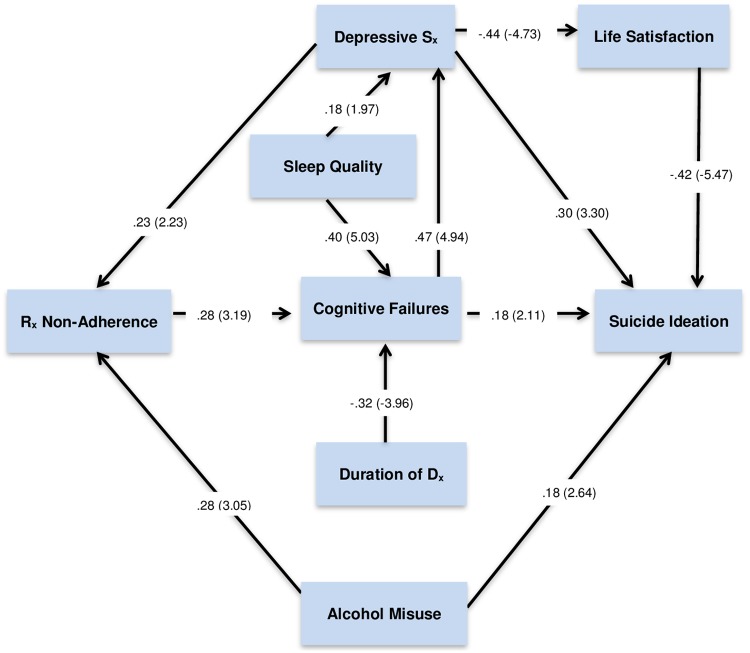
Path analytic model of predictors of suicide ideation among older adults with bipolar disorder.Note. Suicide ideation = GSIS, Depressive Sx = PHQ-9, Alcohol misuse = AUDIT, Rx adherence = MAS, Cognitive failures = CFQ, Sleep quality = PSQI, Life satisfaction = SWL. Parameters expressed as maximum likelihood estimates (standardized solution). Parenthetical numbers indicate significance levels for parameter estimates (statistically significant critical ratios values > |1.96|).